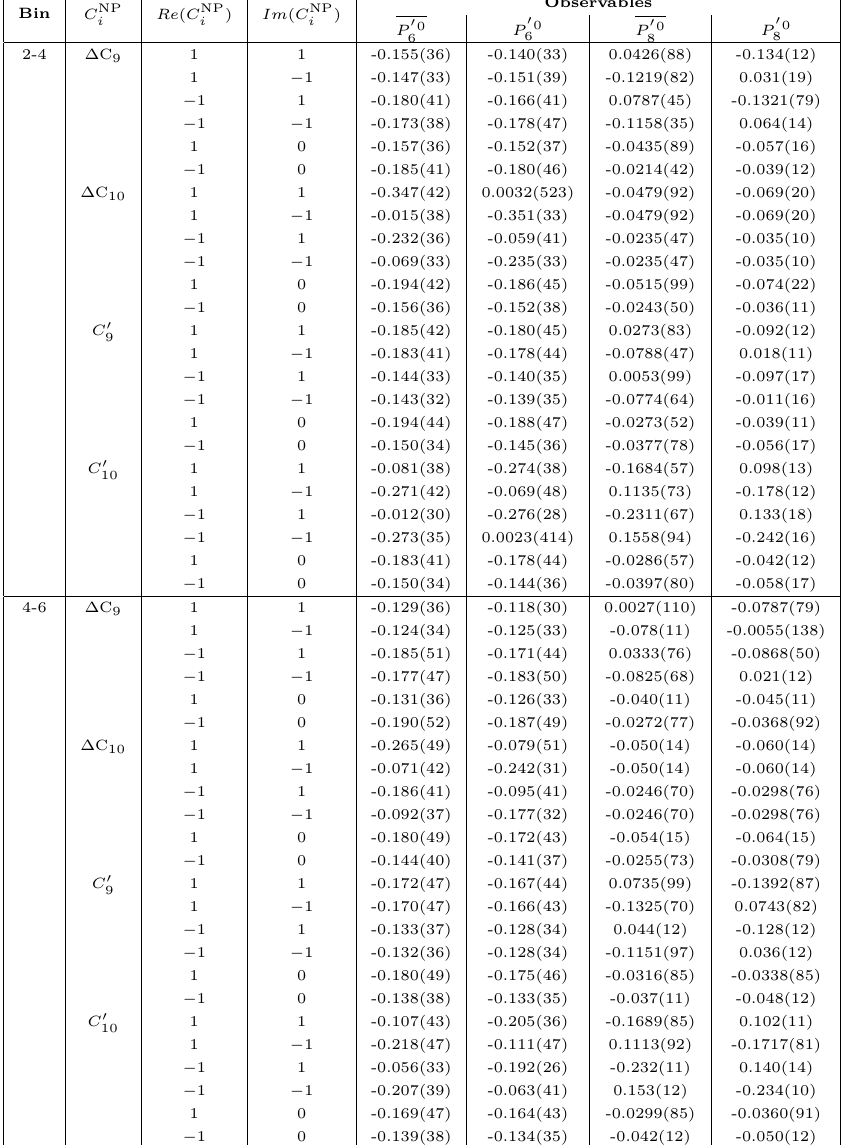
Table 35 . The dependence of some of the optimized observables corresponding to tagged and B 0 → ρ 0 ll on the real and imaginary parts of the NP WC’s ∆ C 2 − 4 and 4 − 6 GeV 2 for a few benchmark values of the real and imaginary parts of the corresponding